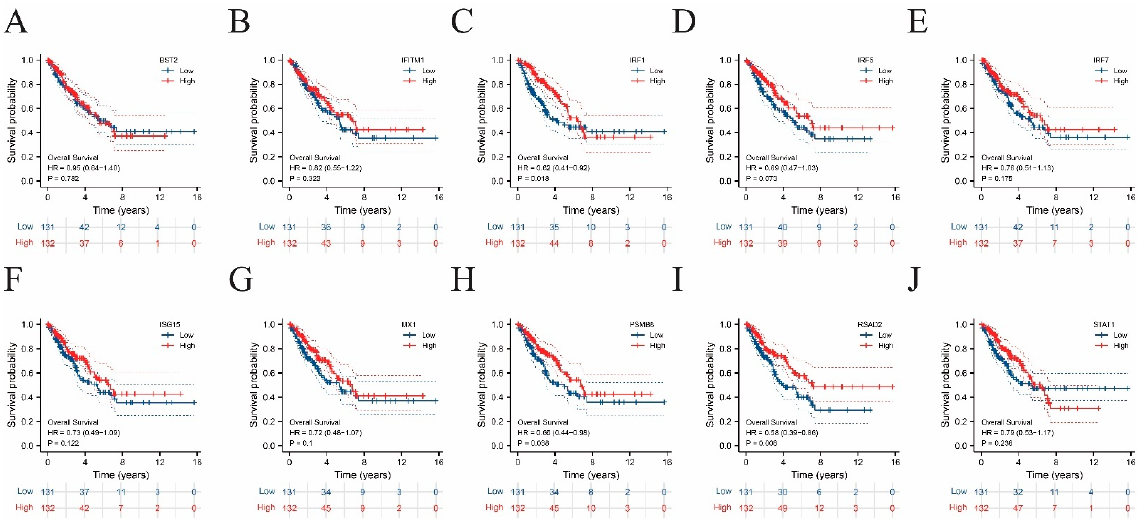
Figure 6. Survival analysis performed on the ten hub